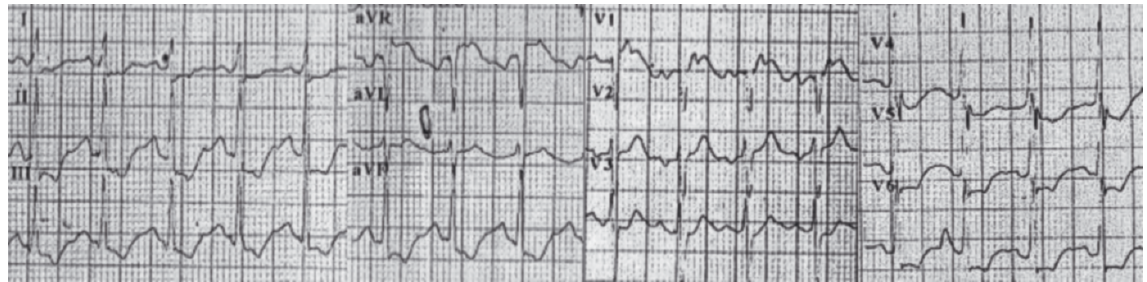
Figure 2. Case 2: Sinus tachycardia 138 beats/minute with ST segment depression (2-4 mm) in antero-lateral and inferior leads, and ST segment elevation 1-3 mm in leads aVR, V1.